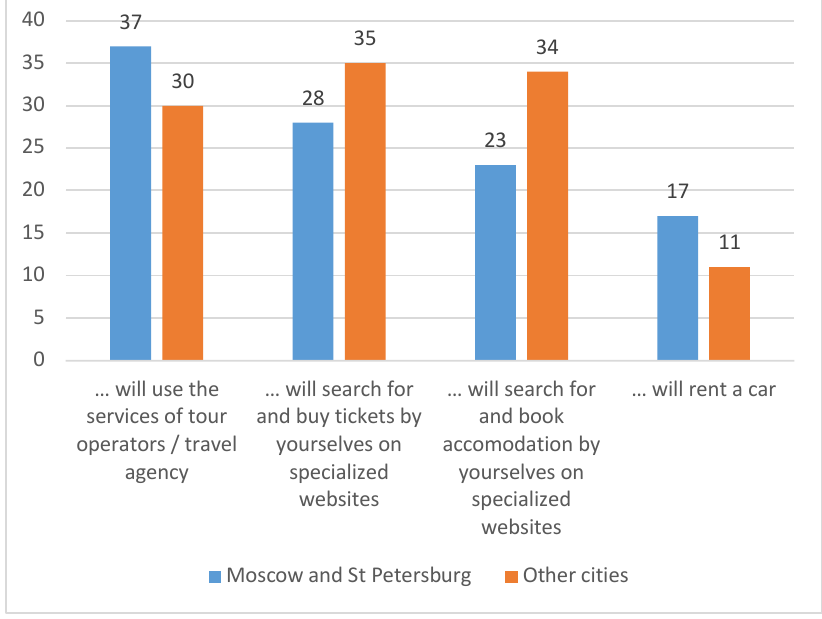
Fig. 4. The results of respondents’ answers by city (Source: